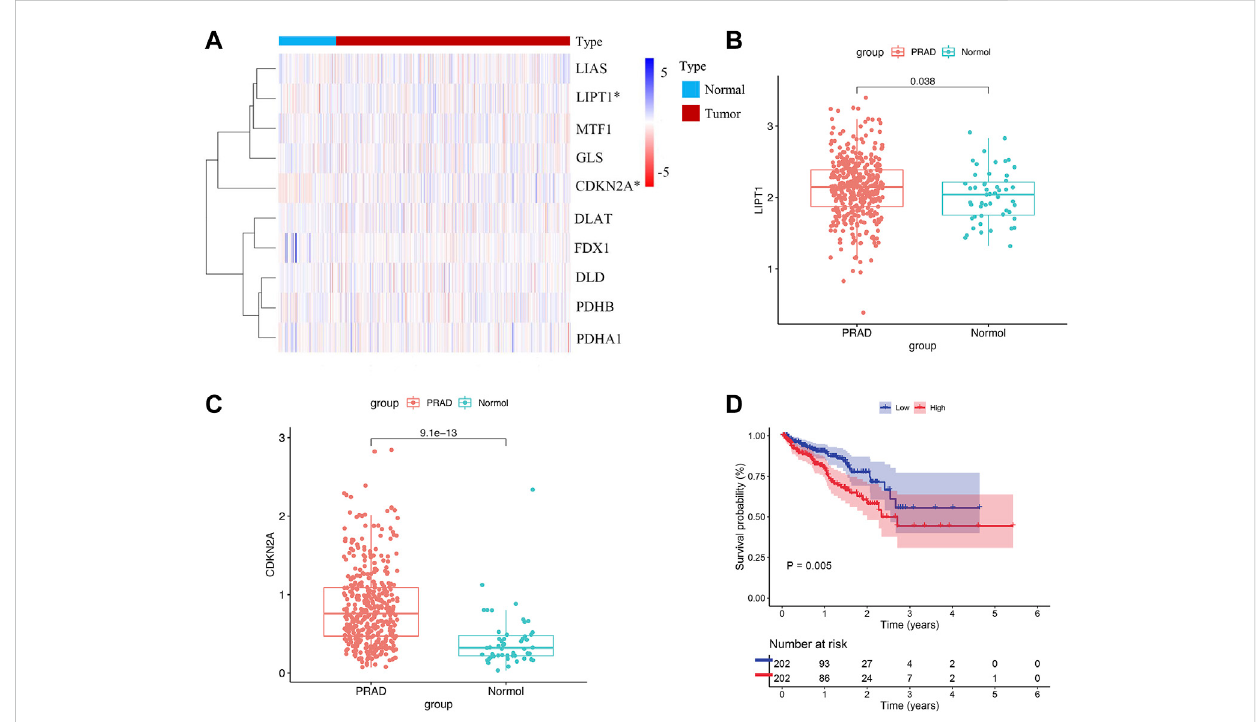
FIGURE 2 Cuproptosis-related genes expressed in PCa patients and prognostic value. (A) Expression levels of ten genes. (B, C) The comparison of LIPT1 and CDKN2A between PCa tissues and normal tissues. (D) The prognostic value of